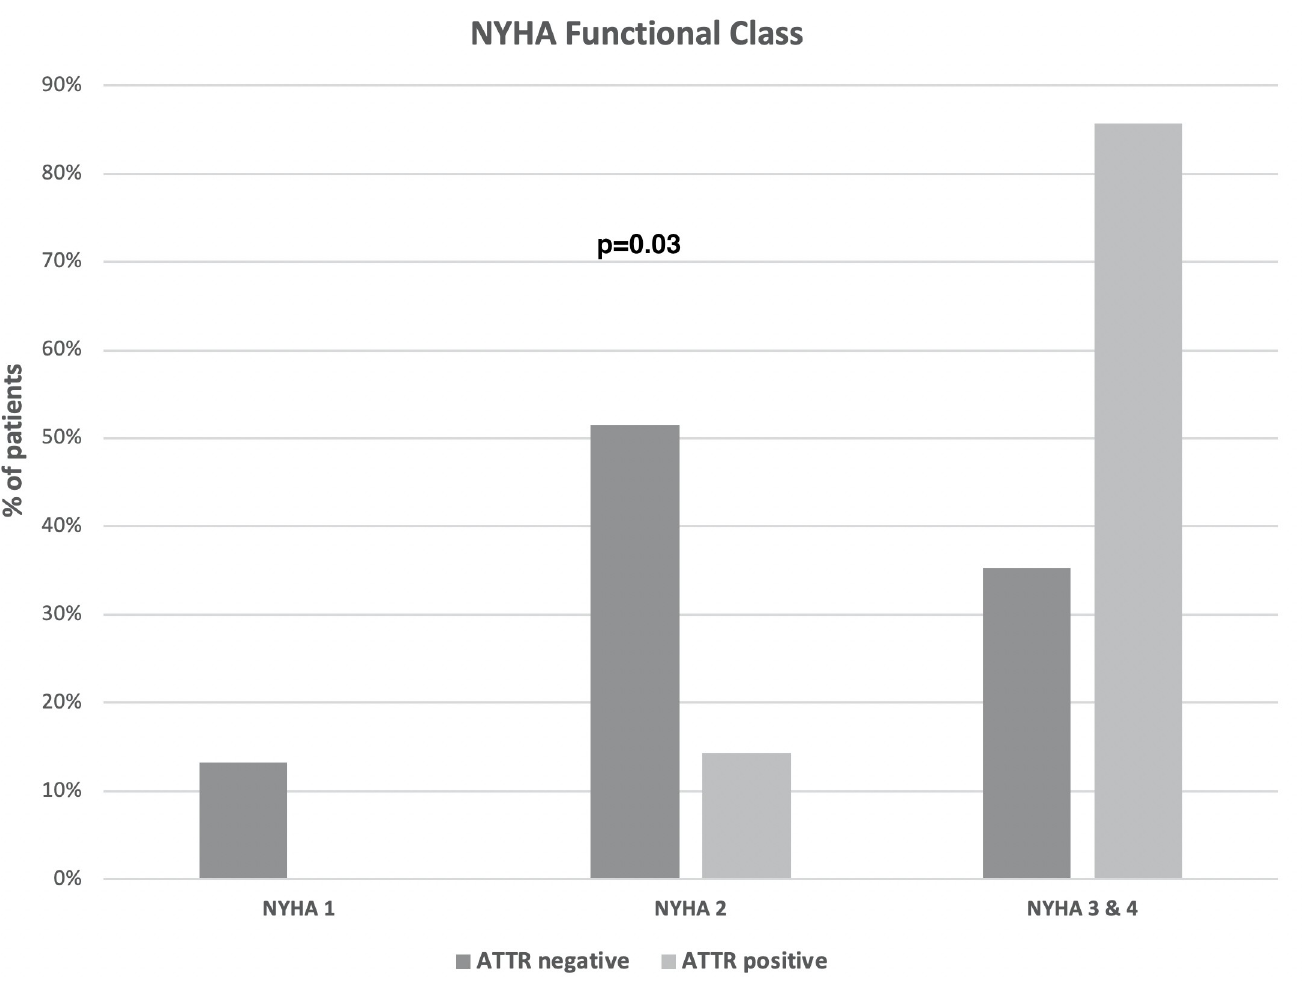
Fig 1. Comparison between patents with and without ATTR-CA according to the NYHA FC (NYHA FC, New York Heart Association Functional Class).